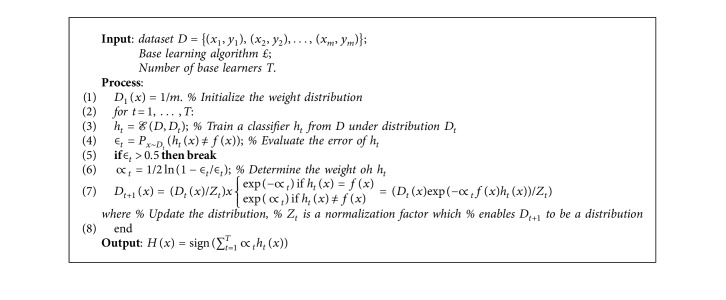
AdaBoost algorithm.